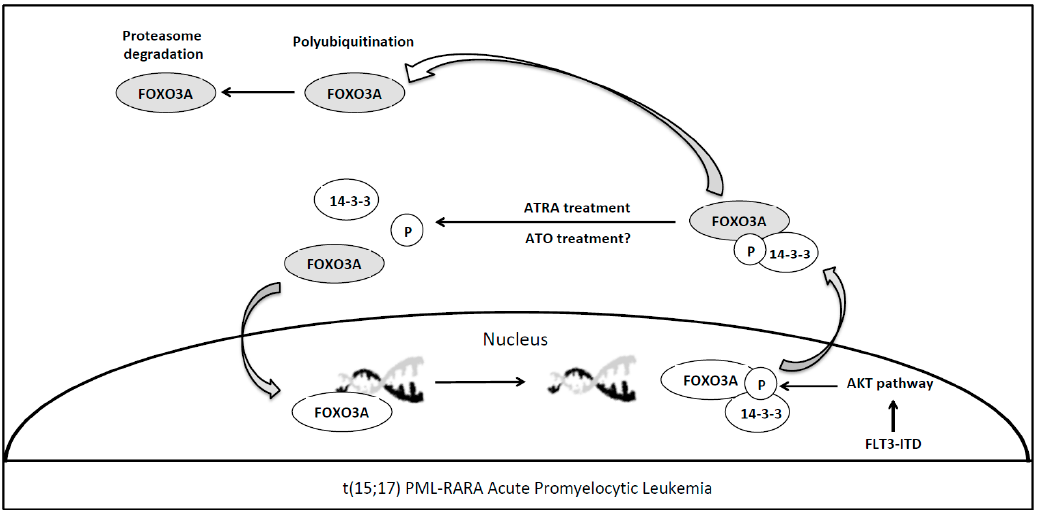
Figure 2. ATRA mediated reactivation of FOXO3A in t(15;17) PML-RARA acute promyelocytic leukemia. Nuclear FOXO3A (active form), once phosphorylated, interacting with 14-3-3 protein is exported to the cytoplasm losing its function [52]. The phosphorylation of FOXO3A, and its consequent loss of function, may be regulated by AKT pathway aberrantly activated in case of AML driver mutations such as FLT3-ITD [53]. All-trans retinoic acid (ATRA) treatment is able to reduce FOXO3A phosphorylation and to induce the relocation of the transcription factor into the nucleus, where the protein leads to blast apoptosis [40]. Arsenic trioxide (ATO) treatment in this cellular context needs to be better assessed. Light grey shows the FOXO3A inactive form.